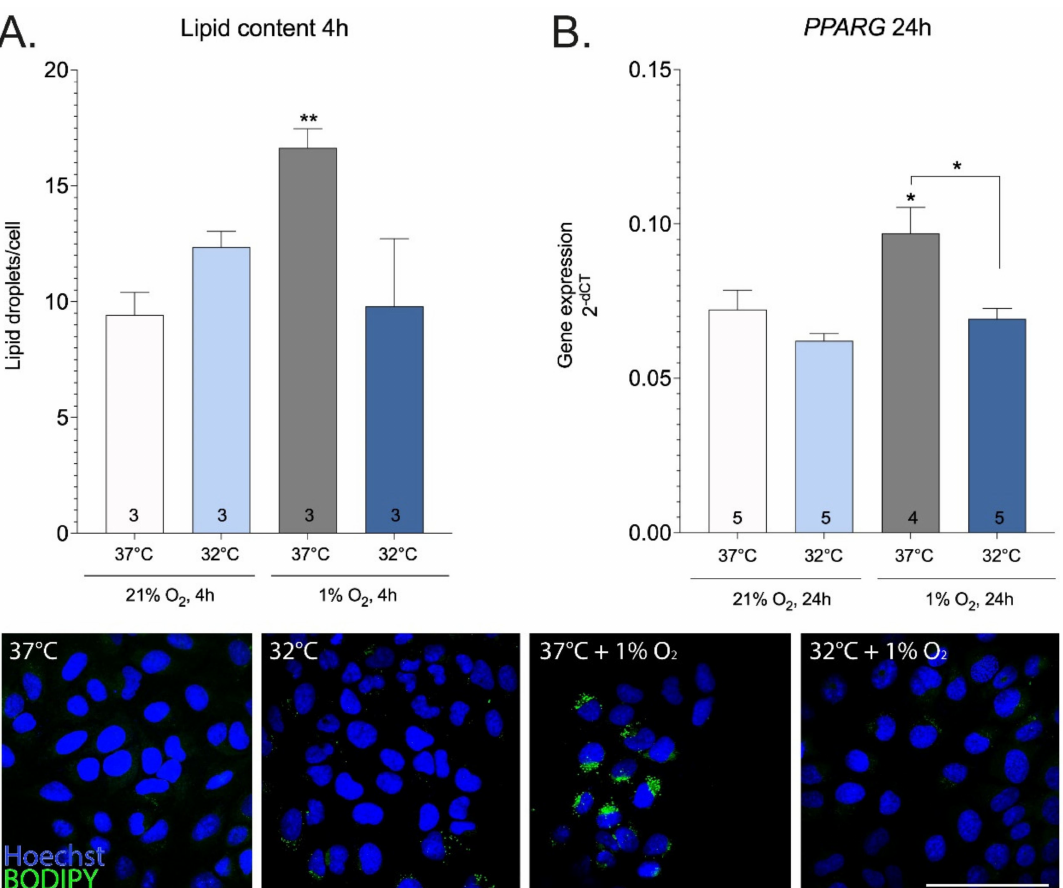
Figure 5. Lipid content ( A ) and PPARG gene expression ( B ) under mild hypothermia (32 ◦ C) and 1% O 2 . Treatments were performed for 4 or 24 h. Scale bar = 100 µ m. Asterisks refer to a statistically significant difference with respect to corresponding genotype at 37 ◦ C unless indicated otherwise. Numbers in bars indicate sample size. Values are expressed as mean ± SEM. Statistical analysis was performed with unpaired t test with Welch correction ( A ) or One-way ANOVA with post-hoc Tukey HSD Test ( B ). *, p < 0.05; **, p <